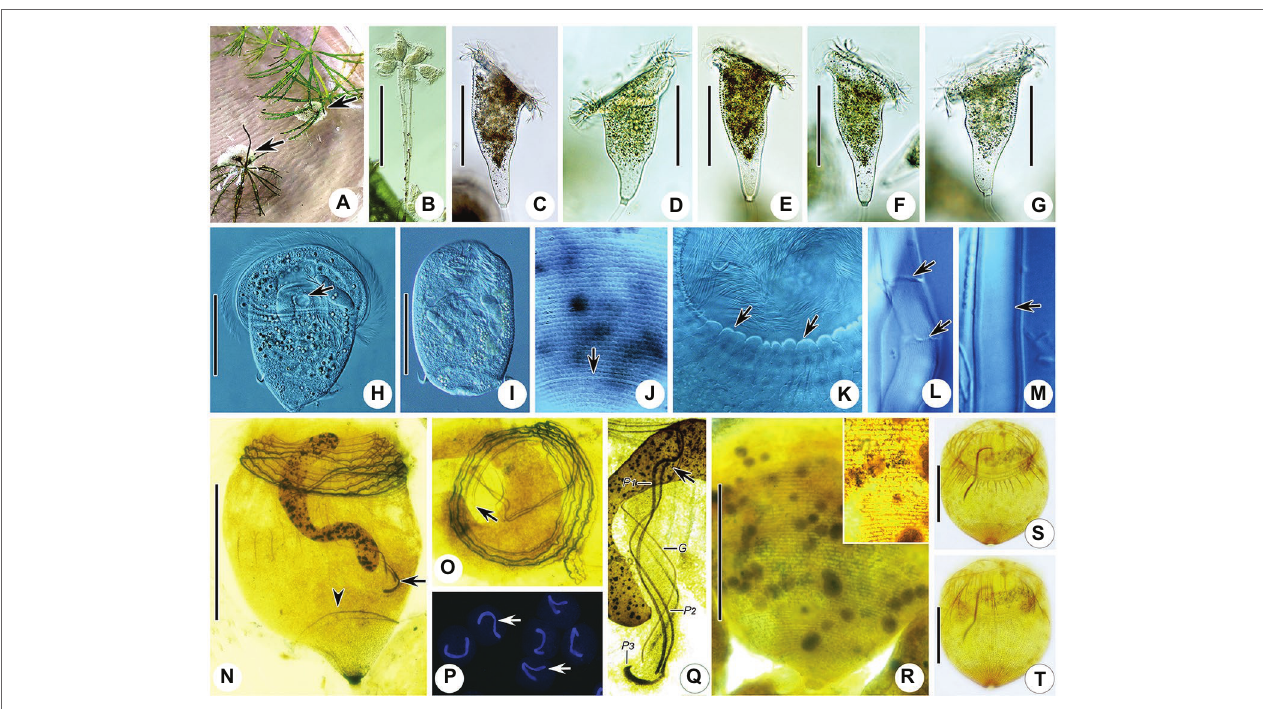
FIGURE 4 | Photomicrographs of Campanella sinica n. sp. in vivo (A–M) , after protargol staining (N,O,Q,S,T) , after Hoechst-33342 staining (P) , and after dry nitrate silver staining (R) . (A) Colony (arrows) on aquatic plant. (B) Immature colony. (C–G) Different individuals, showing the variation of zooid shape. (H) A compressed zooid, arrow indicates the contractile vacuole. (I) Telotroch. (J) Pellicular striations, arrow indicates the aboral trochal band. (K) Detail of peristomial region of a contracted zooid, arrows indicate the peristomial lip. (L,M) Showing that the stalk is hollow (arrows). (N) Holotype specimen, showing the infraciliature and macronucleus, arrow indicates P3, arrowhead indicates the aboral trochal band. (O) Oral ciliature, apical view, arrow indicates the beginning of the oral ciliature. (P) Showing the macronucleus (arrows). (Q) Infundibular polykineties, arrow marks the anterior end of P2. (R) Silverline system. (S,T) Myoneme system. G, germinal kinety; P1–3, infundibular polykineties 1–3. Scale bars = 80 μ